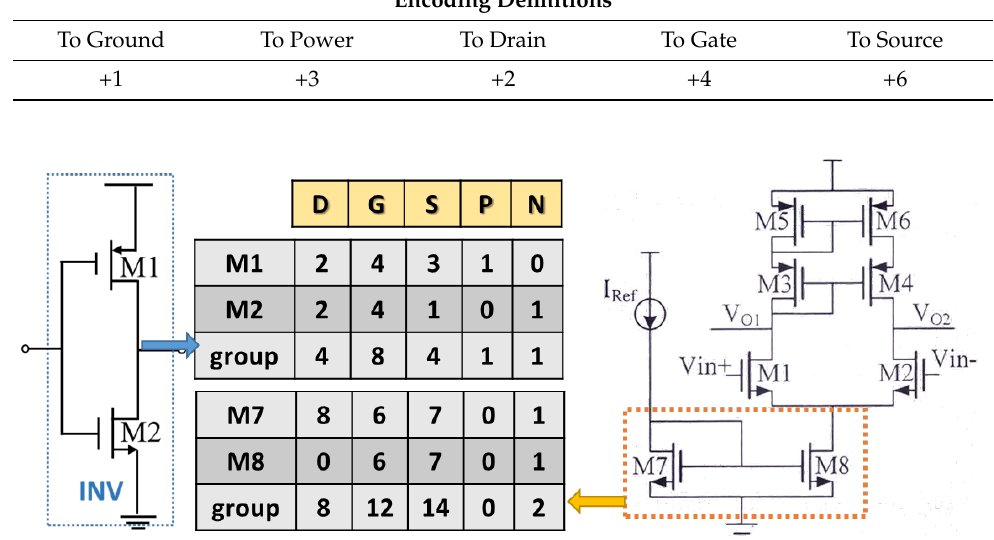
Figure 6. Illustration of proposed encoding scheme. Table 1. Definitions of transistor encoding.